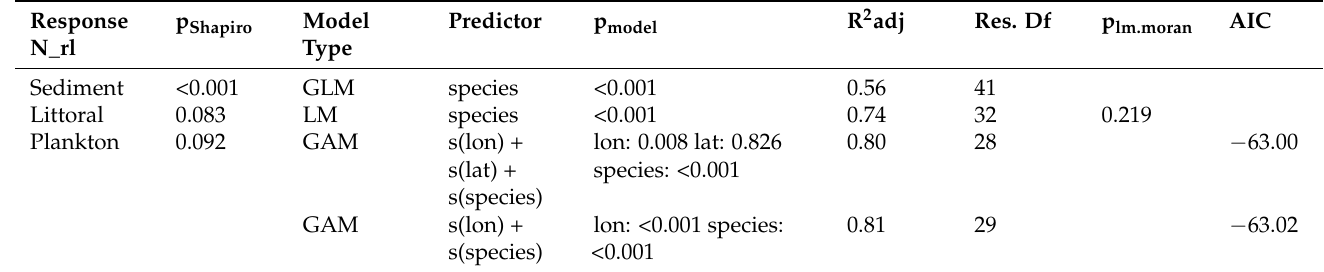
Table 3. A significant correlation between the number of RL species (N_rl) and species richness was detected for all assemblages based on LMs, GLMs, and GAMs. For planktic assemblages, longitude (lon) was additionally correlated to N_rl. p -values for the Moran-test of the linear model residuals and AIC values are given where relevant. If smoothers were included in GAMs, this is indicated by placing the predictor within